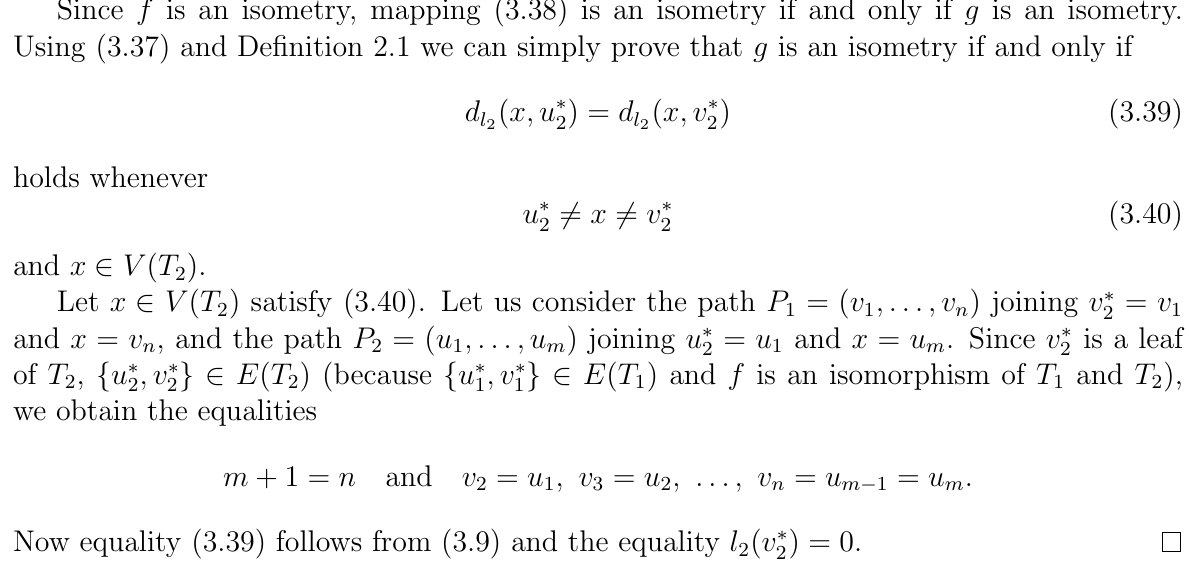
= d and T l l V ( G ) l